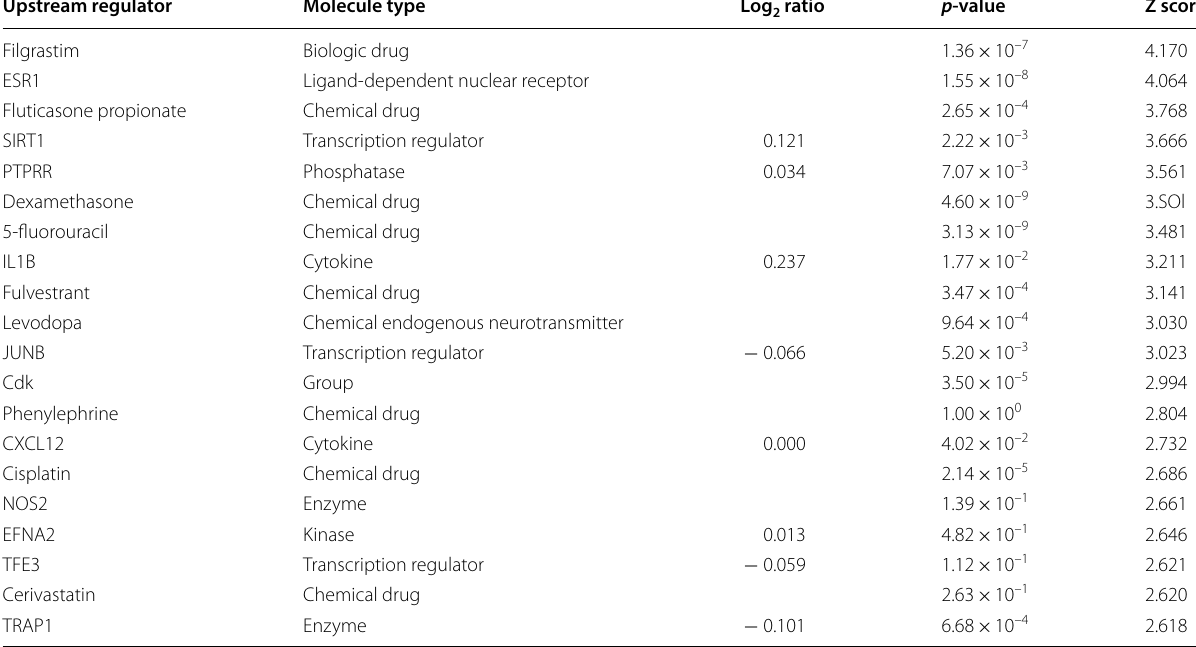
Table 1 Ingenuity pathway analysis uncovered the top 20 upstream regulators Upstream